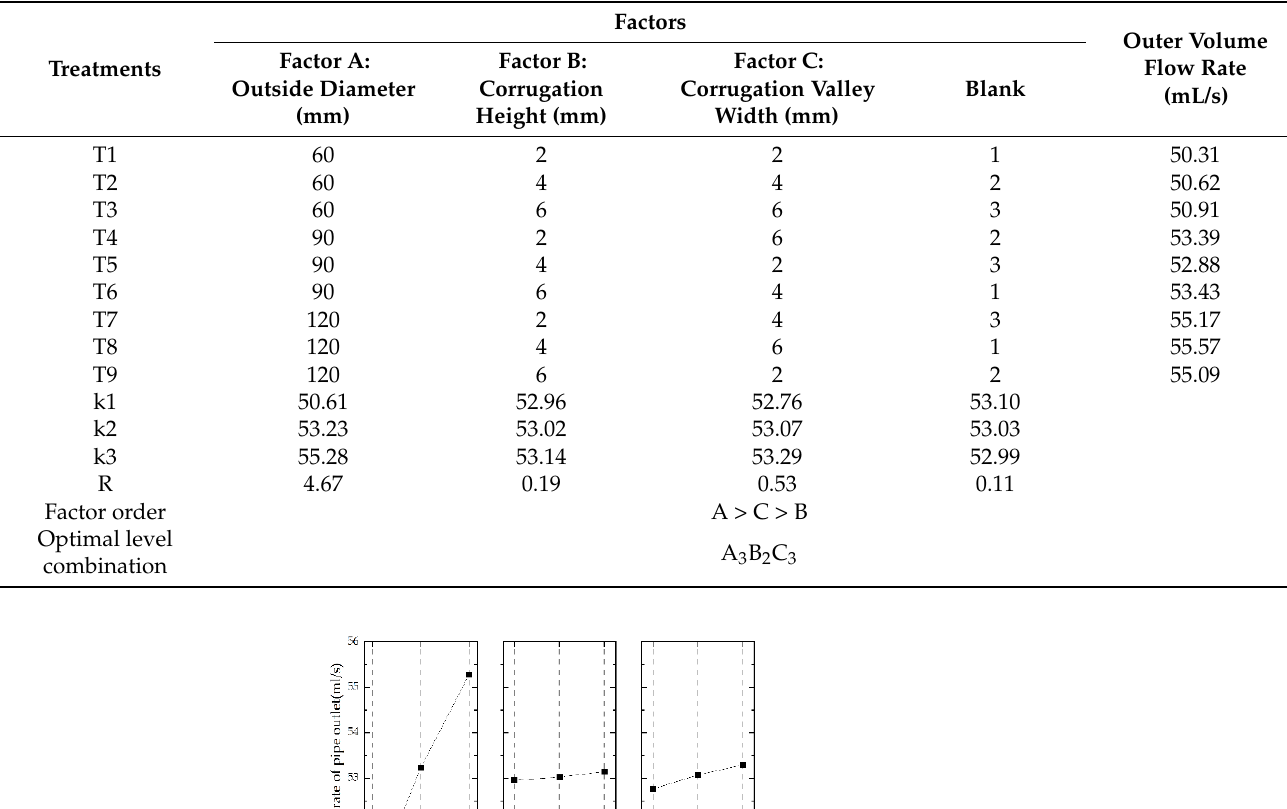
Table 6. Range analysis of the volume flow rate of the drainpipe.